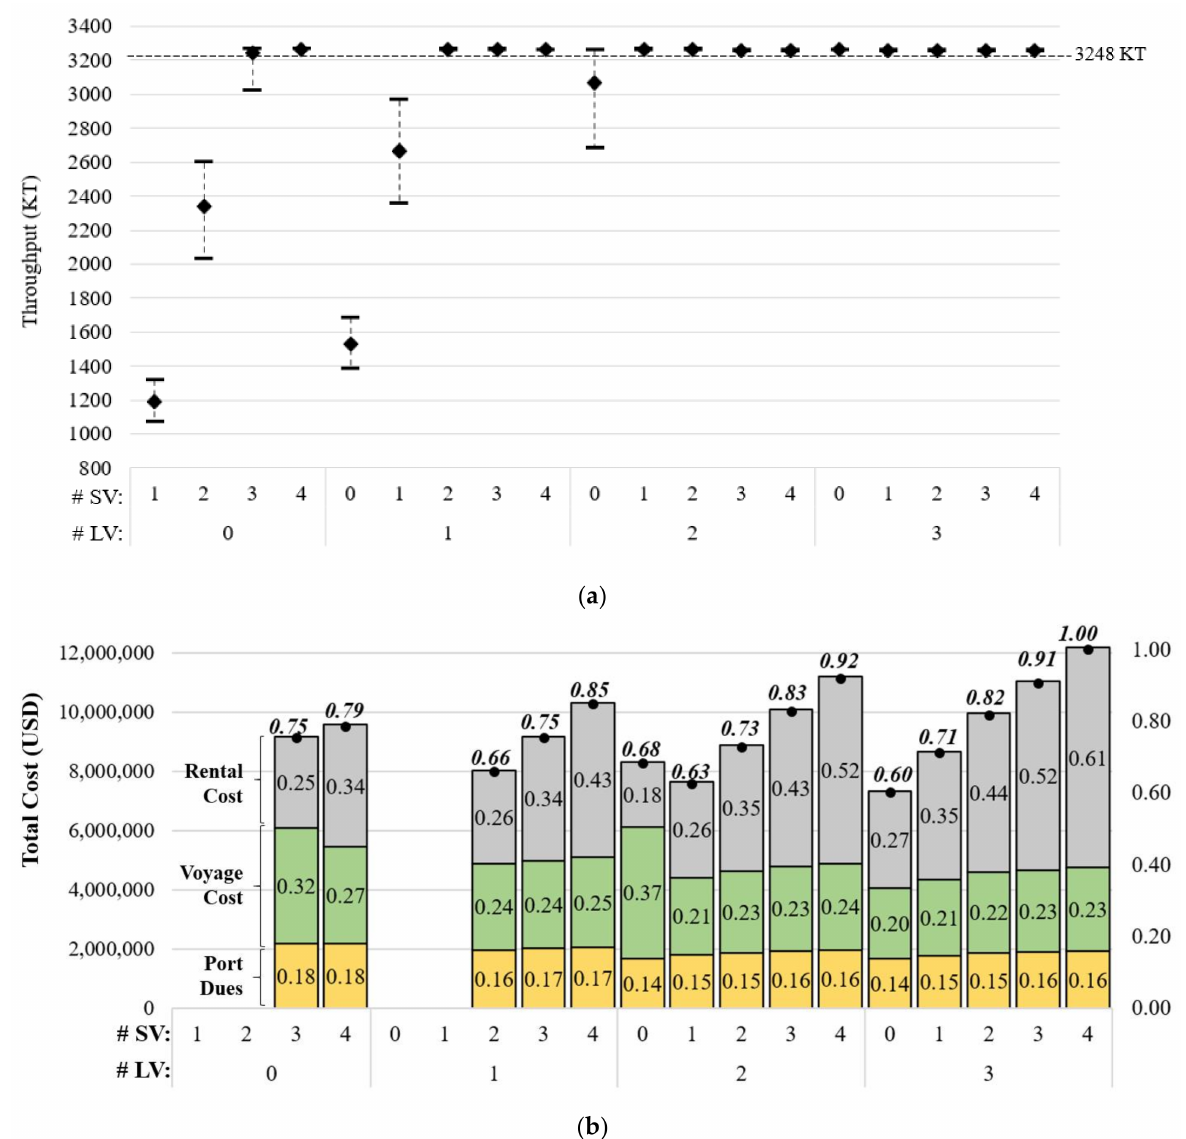
Figure 5. Impact of the number of vessels and voyage speeds under FAFU: ( a ) transported volume; ( b ) cost breakdown at the optimal travel